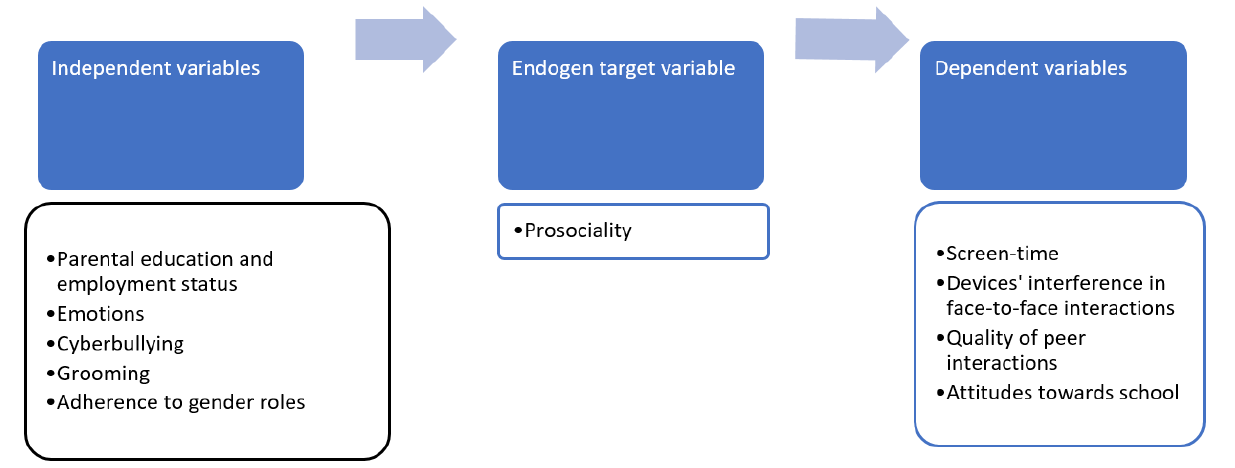
Figure 1. Theoretical path model concerning prosociality indicator.